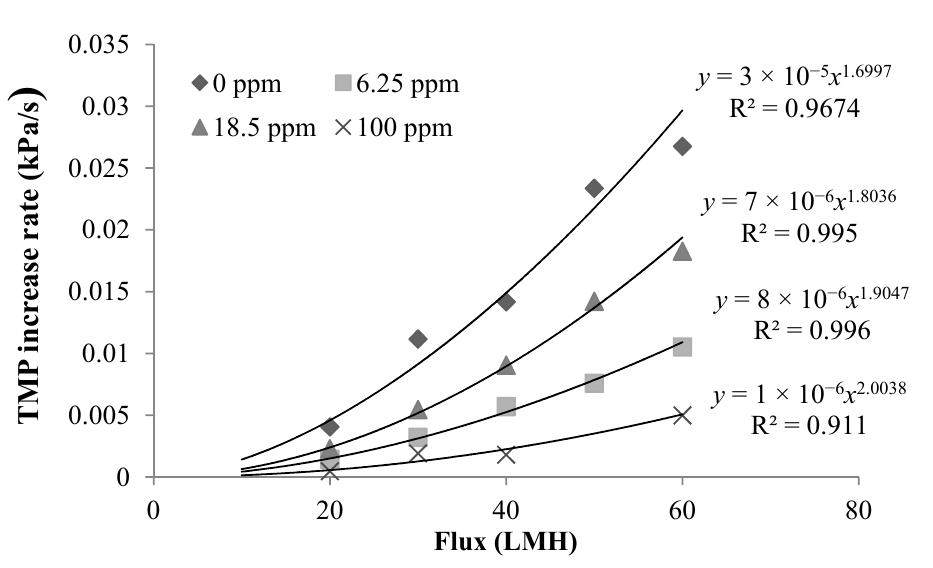
Figure 5. Effect of flux on TMP rate for filtration with different calcium concentrations (calcium concentrations: 0 ppm, 6.25 ppm, 18.5 ppm and 100 ppm) at 10 ppm sodium alginate concentration and 2 mM sodium bicarbonate